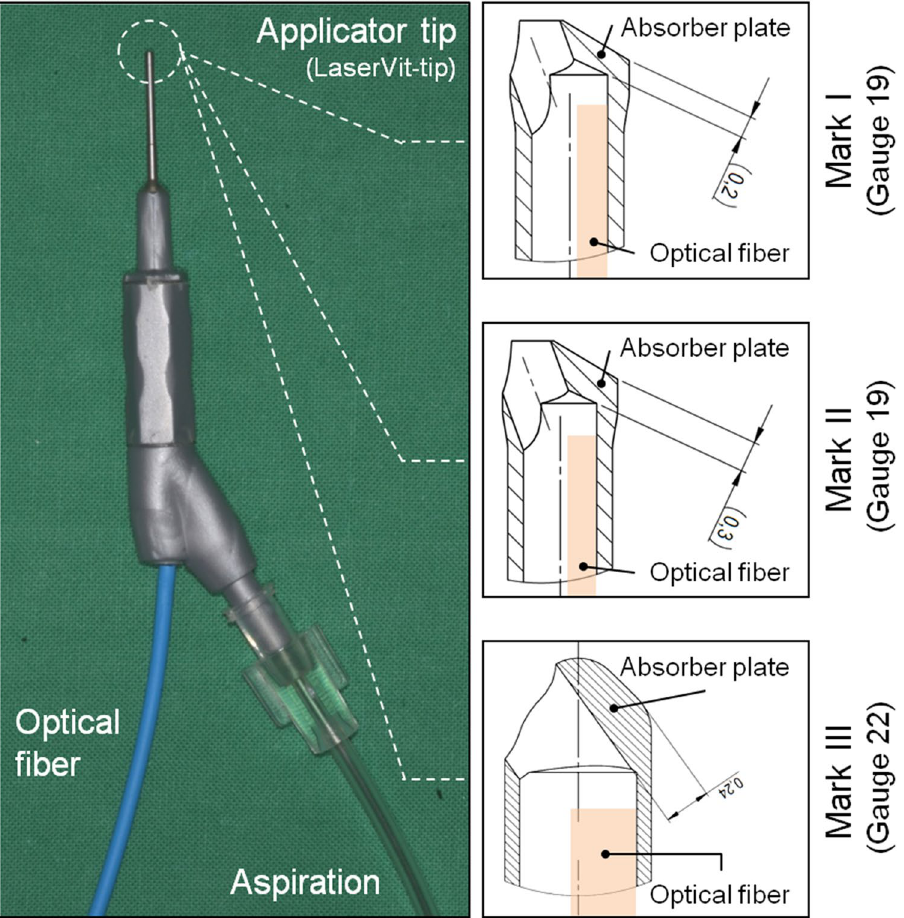
Figure 1. Ophthalmological handpiece used for vitreous body removal. An overview is shown on the left-hand side of the figure. The optical fiber as well as the aspiration tube is adapted to the handpiece. The applicator (LaserVit-tip) is at the end of the handpiece. Technical drawings of the different LaserVit-tip designs (Mark I-III) are shown on the right-hand side of the figure. Technical details are listed in Table 1.